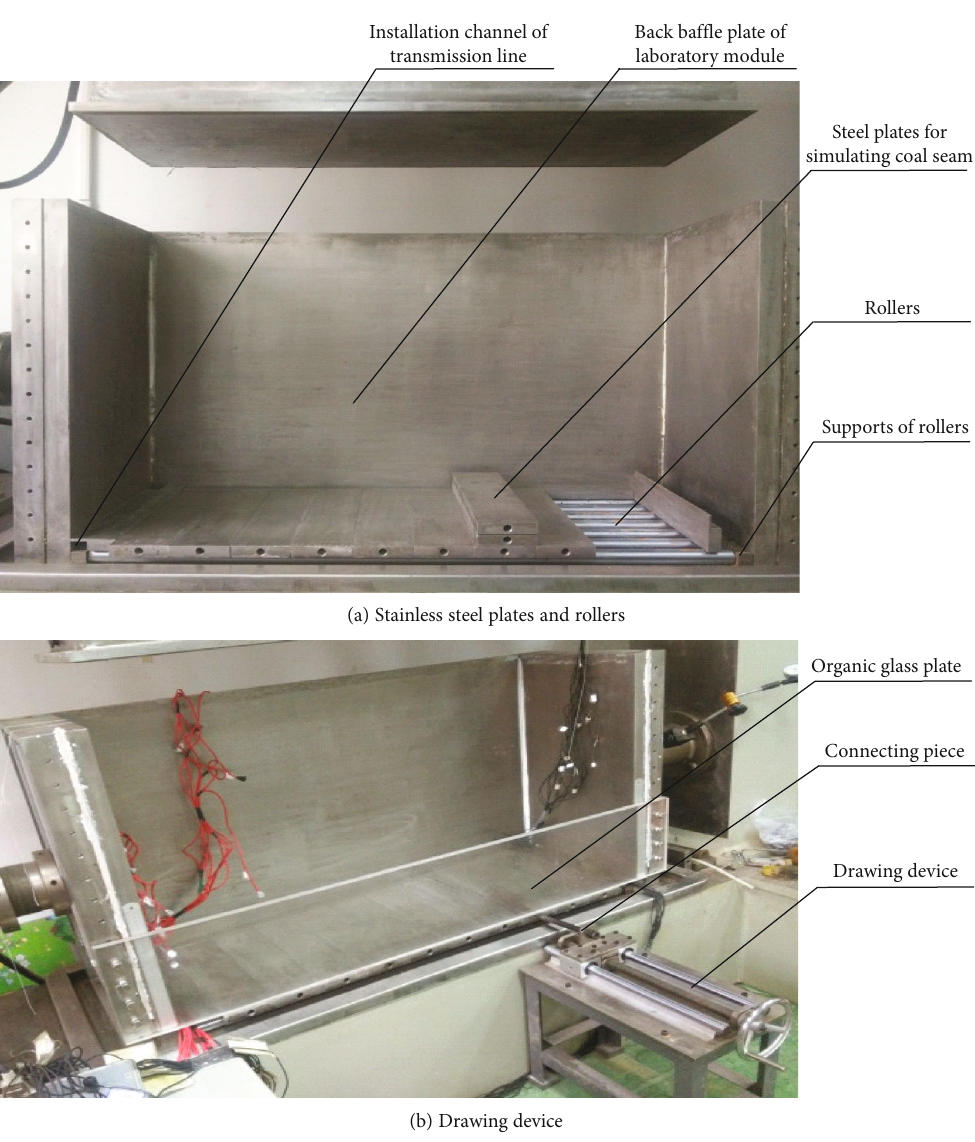
Figure 3: Coal seam mining simulator.